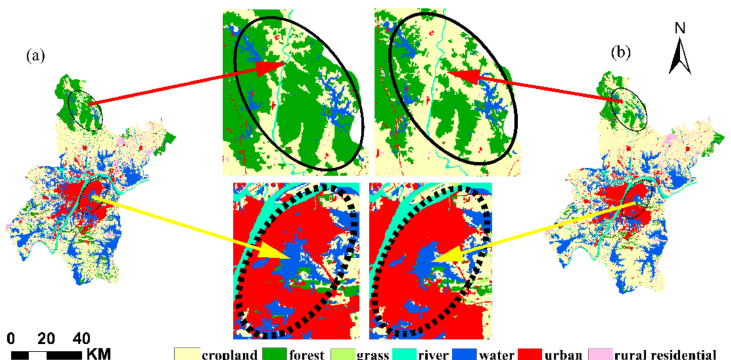
Figure 2. Simulated land use maps of Wuhan in 2020 with different scenarios of: ( a ) NCP (No Cropland Protection) scenario; and ( b ) CP (Cropland Protection)